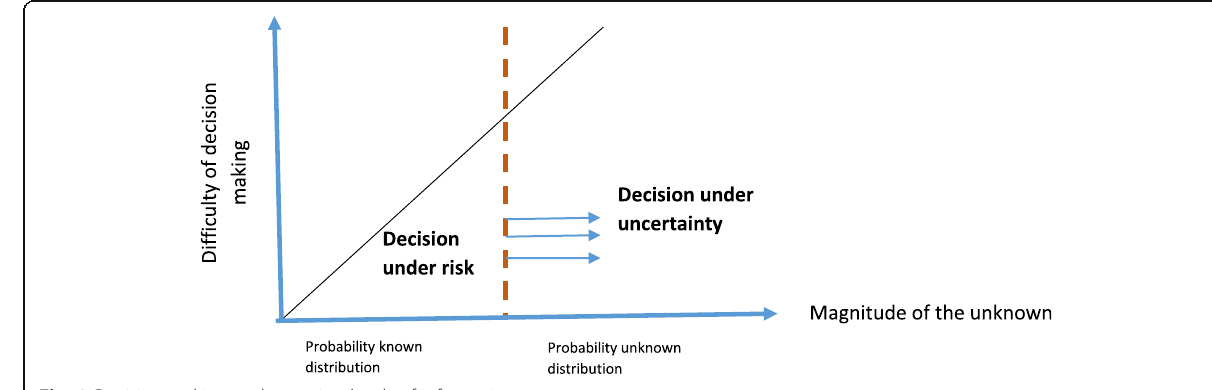
Fig. 2 Decision making under varying levels of